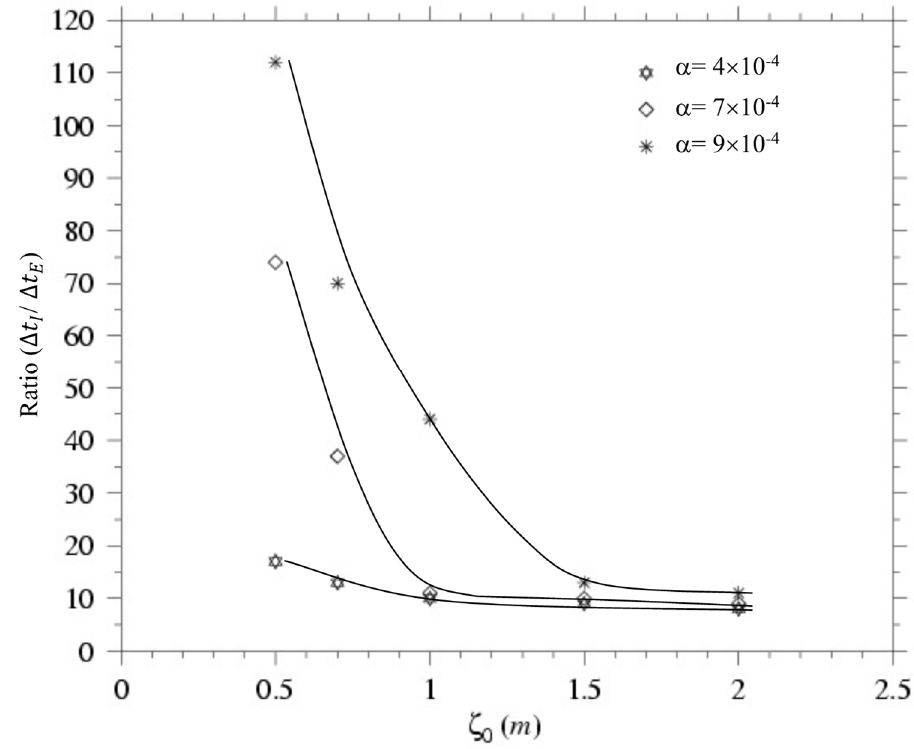
Figure 7. The model-derived relationship of the ratio of the internal to external mode time steps ( ∆𝑡 (cid:3010) / ∆𝑡 (cid:3006) ) with the tidal forcing amplitude ( 𝜁 (cid:3042) ) and the bathymetric slope of the intertidal zone ( α ). ( ∆ t I / ∆ t E ) with the tidal forcing amplitude ( ζ o ) and the bathymetric slope of the intertidal zone ( α In these experiments, ∆𝑡 (cid:3006) = 4.14 s, kb = 6, and D min = 5 cm.